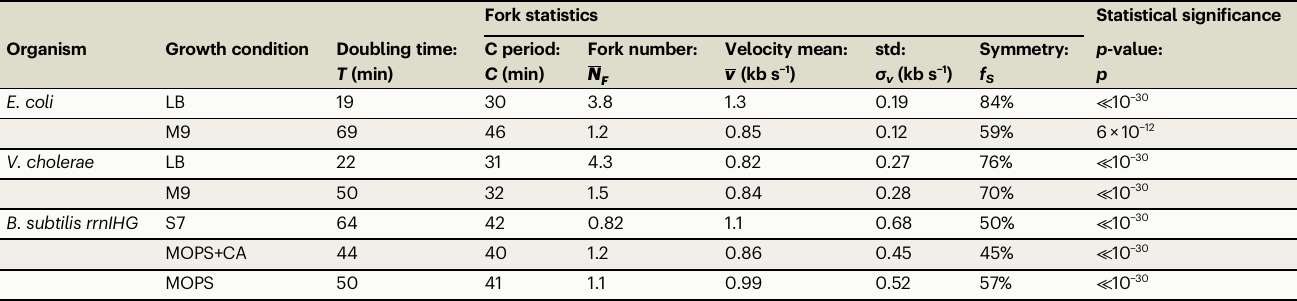
Table 1 | Fork number and velocities under different growth conditions Fork statistics Statistical signi fi cance Organism Growth